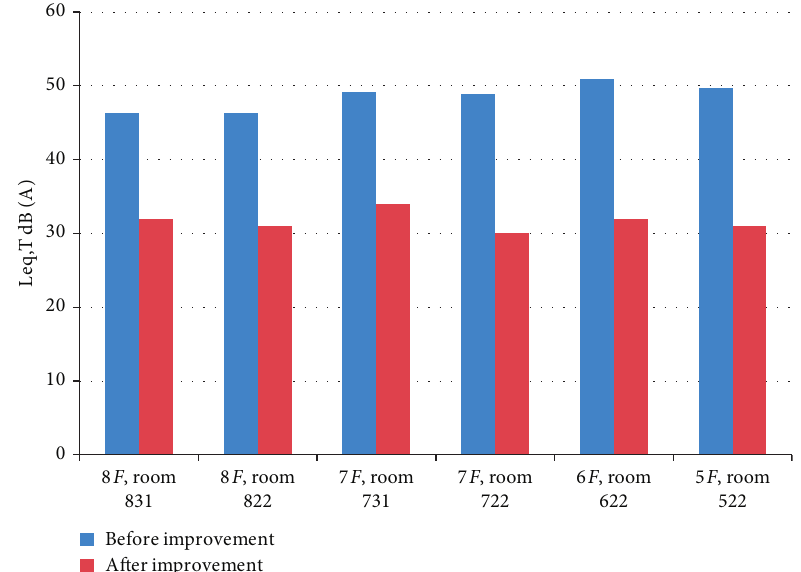
Figure 5: Sound pressure levels in the west residential building with windows closed before and after